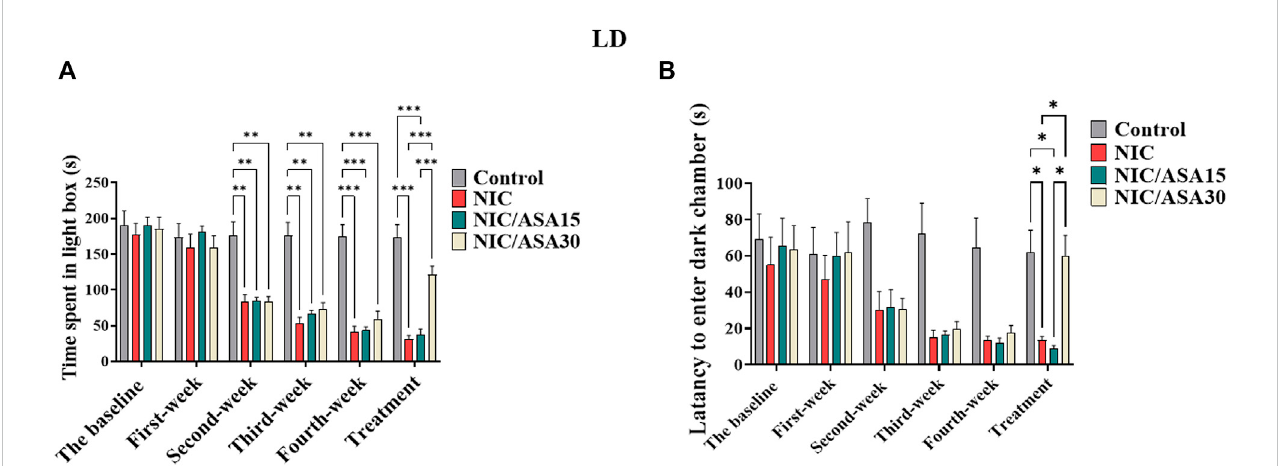
FIGURE 3 Behavioral testing in the LD test (data are presented as mean ± SEM). (A) Time spent in light chamber of the LD box in control, NIC, NIC/ASA15, and NIC/ ASA30rats; (B) LatencytoenterthedarkchamberoftheLDboxinControl,NIC,NIC/ASA15,andNIC/ASA30rats(* p < .05,** p < .01,*** p < .001; n =6foreach